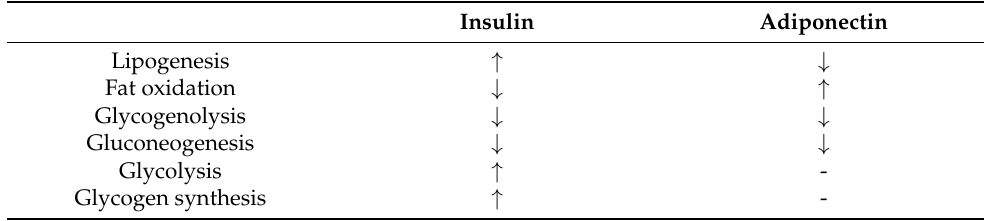
Table 1. Insulin and Adiponectin effects on the